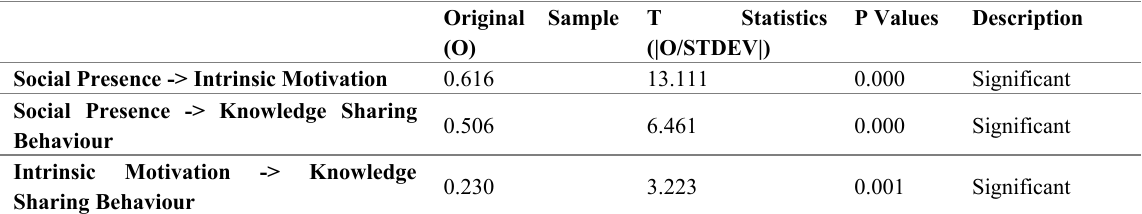
Table 5: Direct Path